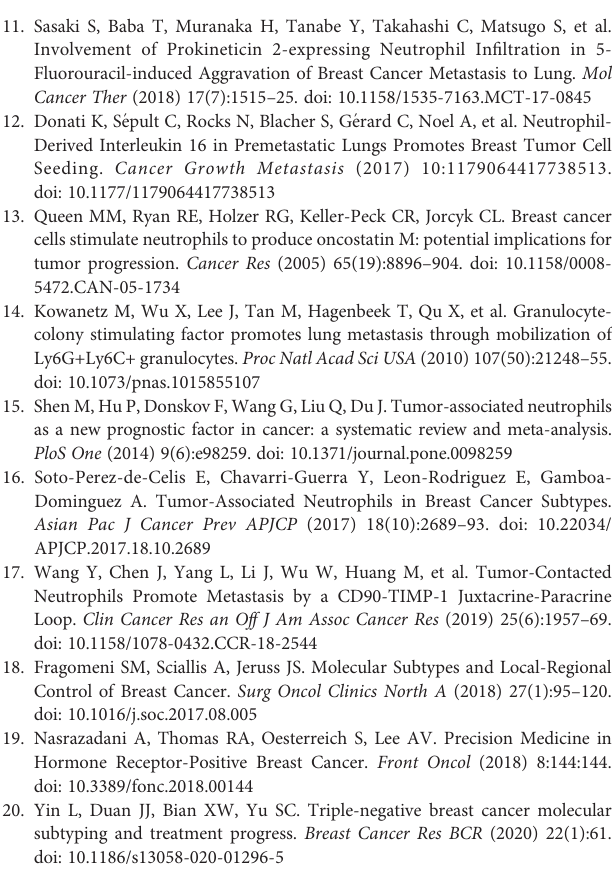
Figure S2 | TNBC cell lines have greater migration and invasion ability than ER+ breast cancer cells. Graph depicting the migration (A) or invasion (B) potential of a panel of TNBC and ER+ cell lines.Results are depicted as mean ± SEMfrom N=3-5 independent experiments represented by each dot. ****P<0.0001, **P ≤ 0.01 when compared with values of MCF-7 cell line (one-way ANOVA with Dunnett ’ s multiple comparisons test). Figure S3 | Active factors secreted from TNBC cell lines induce robust ERK phosphorylation. Representative immunoblots depicting the levels of phospho-ERK and a -tubulin in response to fMLF, CXCL1, and TCM derived from M4, MDA-MB- 231, and MCF-7 cells. Blot is representatives of four independent experiments. Figure S4 | Treatment with PT speci fi cally inhibits Gai dependent signaling. (A, B) Representative fl uorescent endpoint images of neutrophils migrating underagarose towards a gradient 50 µg/ml GM-CSF in the absence or presence of pre-treatment with 500 ng/ml PT for 2 hrs. (C, D) Representative fl uorescent endpoint images of neutrophils migrating towards a gradient 100 nM fMLF in the absence or presence of pre-treatment with 500 ng/ml PT for 2 hrs. Images are representative of at least